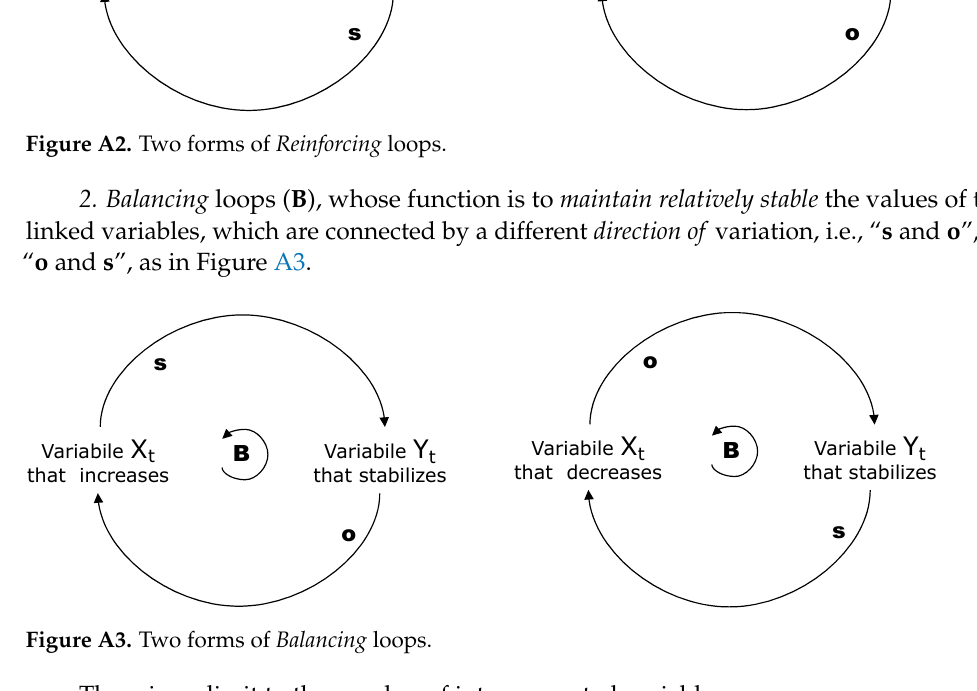
Figure A3. Two forms of Balancing loops. There is no limit to the number of interconnected variables. A system of loops in which all variables are linked by arrows, without an initial and final variable, is defined as a causal loop diagram [123,124]. Systems thinking is not only a technical language but also a discipline.